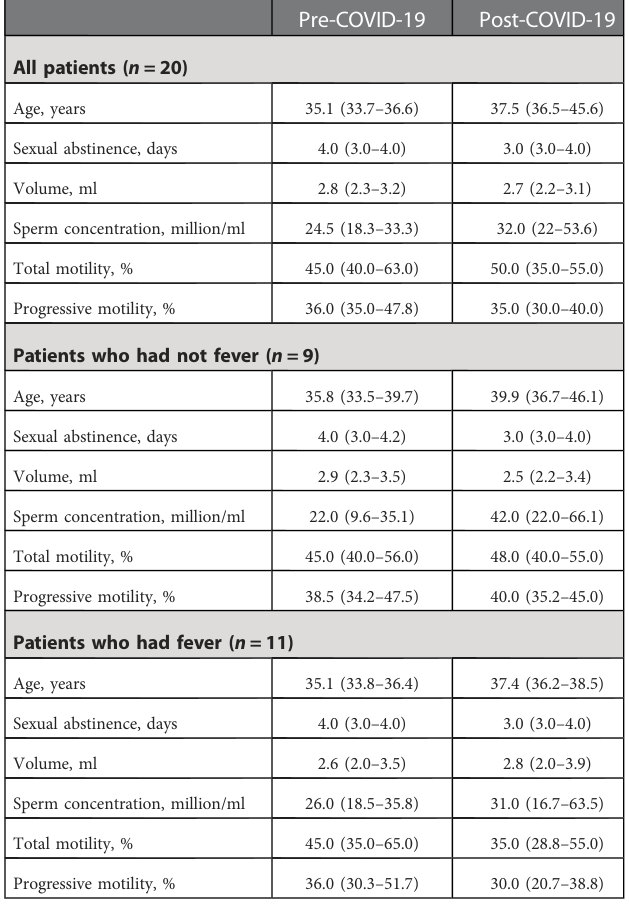
TABLE 1 Demographic and clinic characteristics of the men enrolled in the study and semen parameters before and after COVID-19 disease.